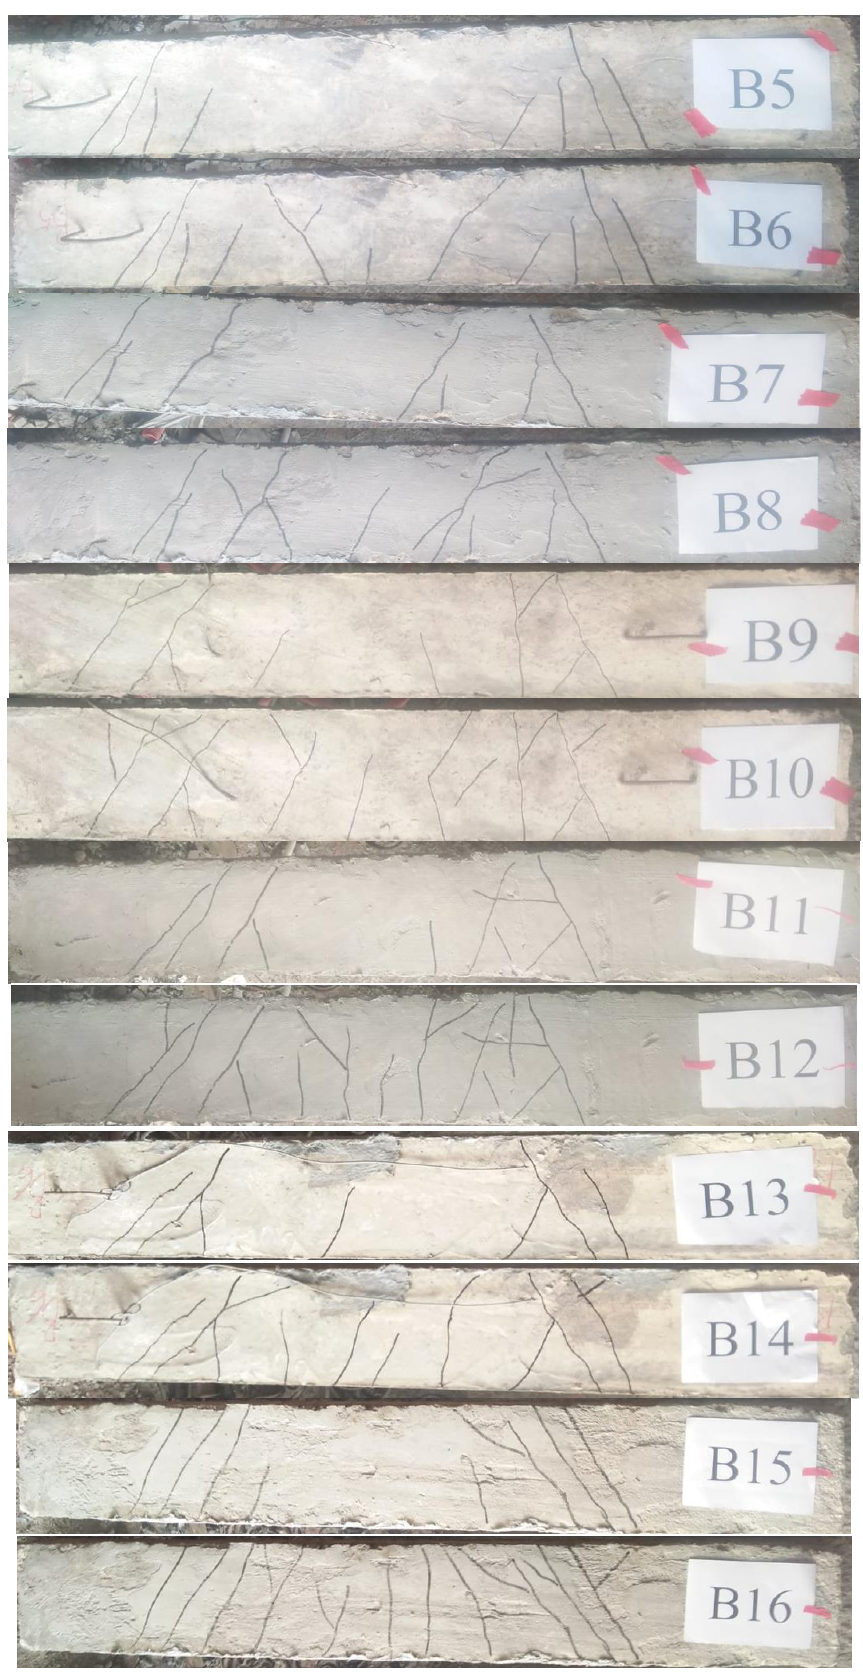
Figure 5. The tested beams ’ crack patterns.